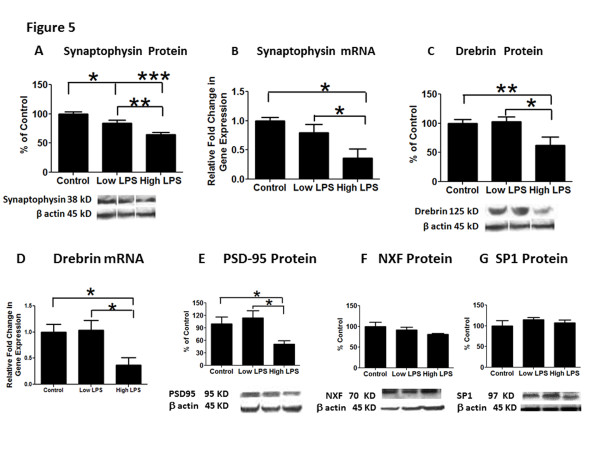
Protein levels of (A) synaptophysin, (C) drebrin and (E) PSD-95 (with representative immunoblots) in control, low- and high-dose LPS rat brain. Data are ratios of optical densities of protein to β-actin, expressed as percent of control and were compared using one-way ANOVA, mean ± SEM (n = 8). mRNA levels of (B) synaptophysin and (D) drebrin in control, low- and high-dose LPS in rat brain, measured using real time RT-PCR. Data are normalized to the endogenous control (β-globulin) and relative to control level (calibrator), using the ΔΔCT method. Comparisons between LPS groups were made using one-way ANOVA, mean ± SEM (n = 8), *p < 0.05, ***p < 0.001.